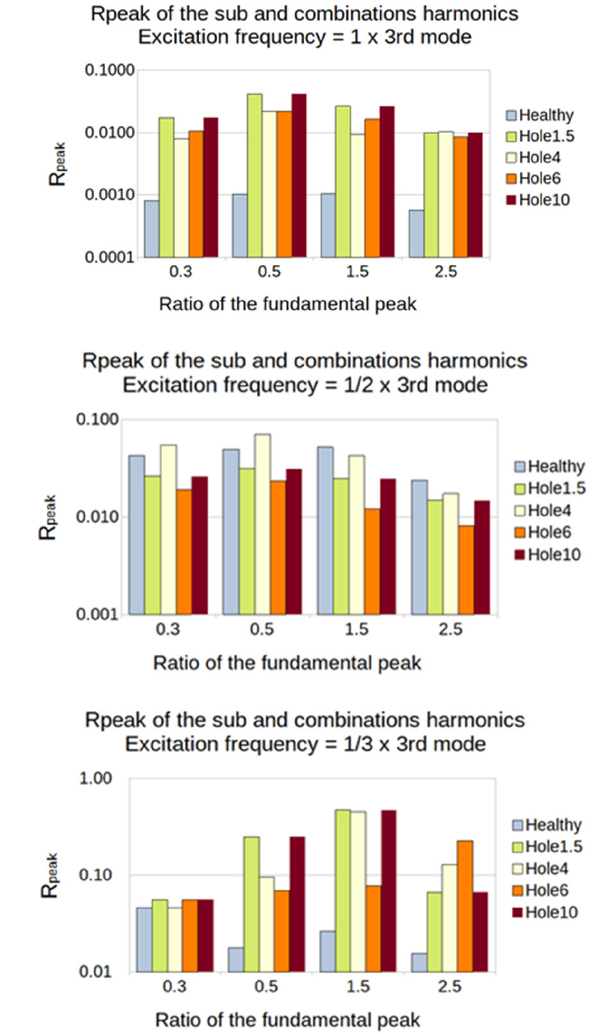
Figure 21. Third natural frequency and its ratio of 1, 1/2 and 1/3 as the frequency of excitation for the PVDF sensor.